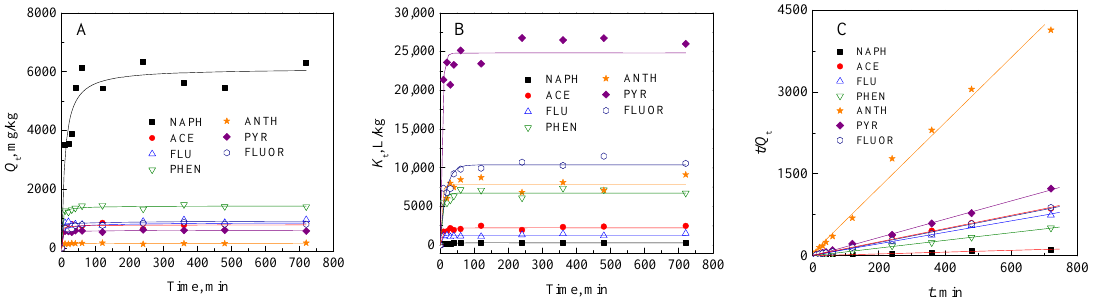
Figure 4. Biosorption kinetics of different PAHs onto inactive biomass. ( A ) biosorption amount; ( B ) normalized parameter K t with water solubility; ( C ) pseudo-second-order kinetic model.